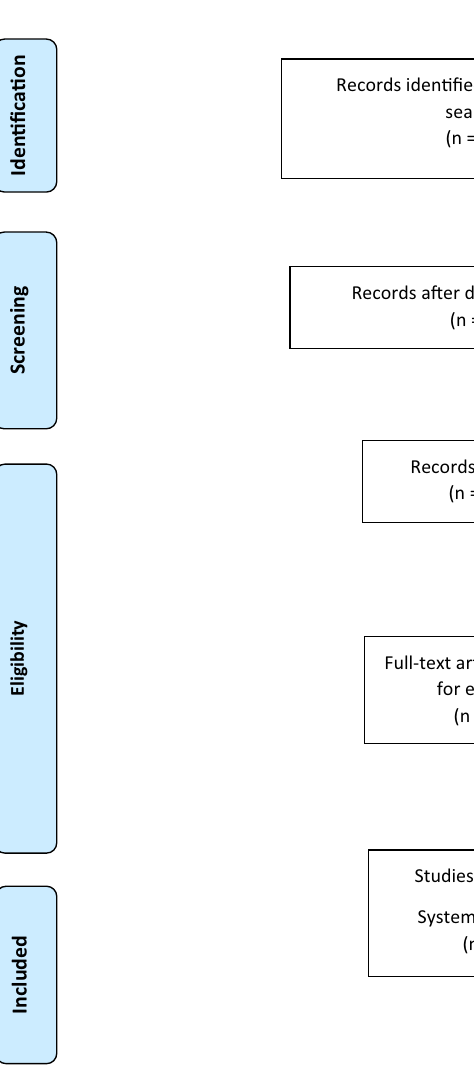
Figure 1: Flowchart of the study selection